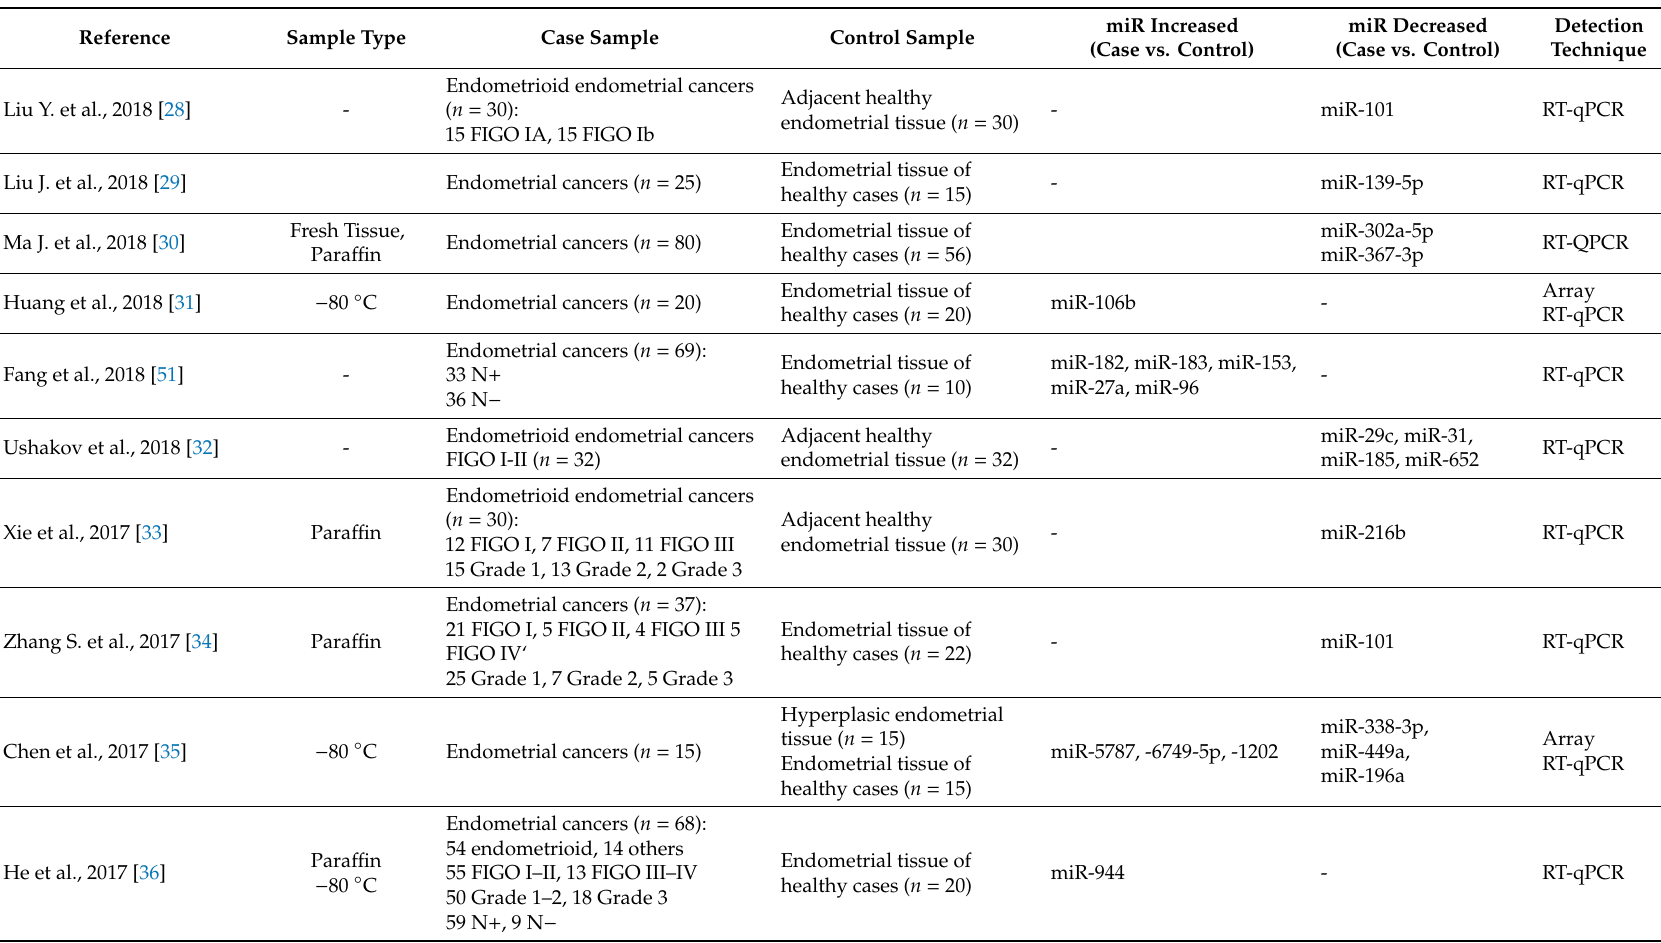
Table 1. Di ff erences in the expression profile of microRNAs (miRs) between malignant endometrial tissue and healthy endometrial